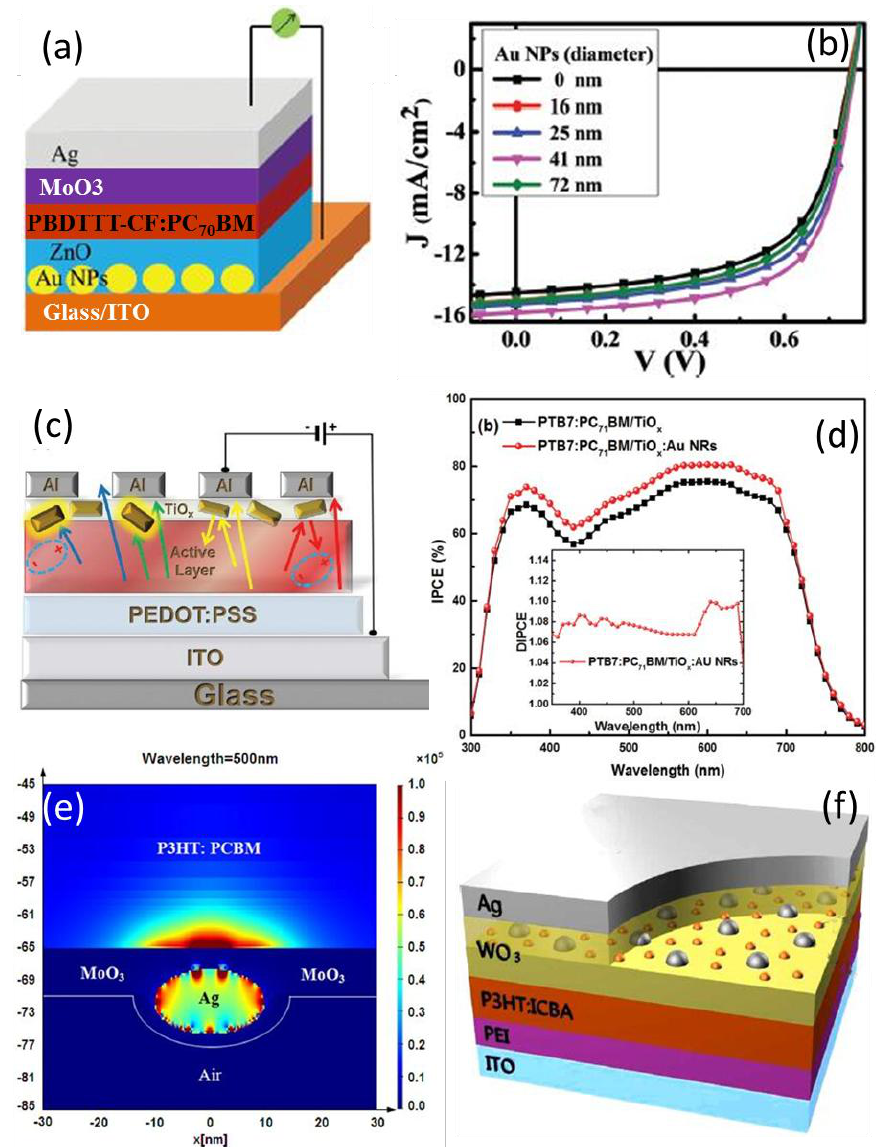
Figure 6. Forward ( a , b ) and backward ( c , d ) scattering when Au NPs/NRs are embedded in ETL [70,73]; ( e ) LSPR mode, which is generated in vicinity of metallic NPs in CTL and scattered into the active layer [89]. ( f ) Bimetallic NPs embedded in HTL [54]. Reprinted with permission from Refs. [54,70,73,89].